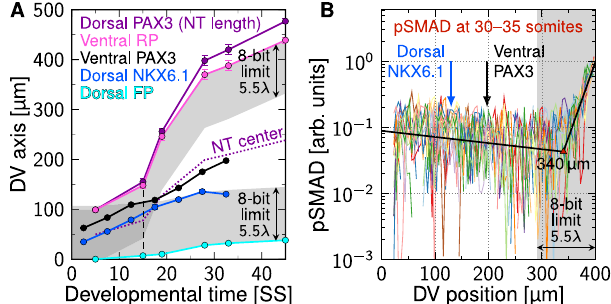
Fig. 3 Technical limits to gradient detection. A NT length (purple) and position of domain limits over developmental time. At later stages, the dorsal NKX6.1 (blue) and ventral PAX3 (black) domain boundaries lie at the edge or outside the 5.5 λ = 107 μ m detection limit of 8-bit microscopy (shadowed). The pink and cyan lines mark the limit of the BMP-secreting roof plate (RP) and SHH-secreting fl oor plate (FP), respectively. The FP and RP lengths were assumed to be equal. The analyzed fi rst 15 somite stages (SS, dashed) coincide with the time window over which 8-bit detection suf fi ces to cover the entire NT. Data are presented as mean values ± SEM from n = 18, 42, 31, 6, 24, 13, 13 measurements for dorsal NKX6.1, n = 22, 33, 42, 15, 32, 38, 28 for ventral PAX3, n = 123 for dorsal PAX3 and FP/RP, reproduced from 9,17 . B The measured GBS-GFP and pSMAD gradients 9 contain an approximately constant noise bed that dominates the signal from within the 8-bit detection limit (shadowed) onward. The dorsal NKX6.1 and ventral PAX3 domain boundaries (arrows) lie far out in the noise bed at later stages. Source data are provided as a Source Data fi